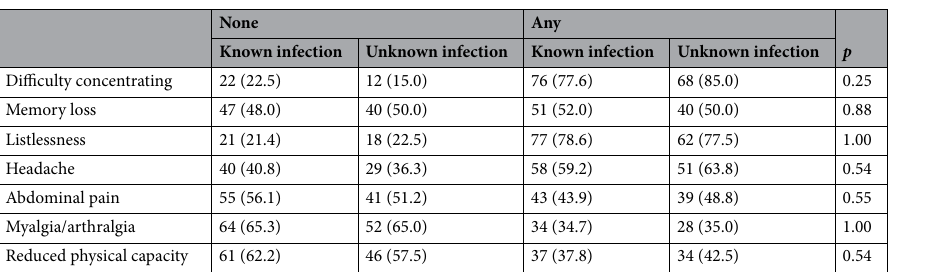
Table 5. Neurocognitive and pain results of seropositive participants to the Long-COVID19-survey—known vs. previously unknown infection ( n (%); Fisher’s exact test: n =